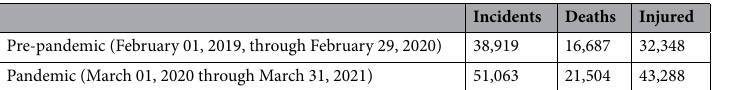
Incidents Deaths